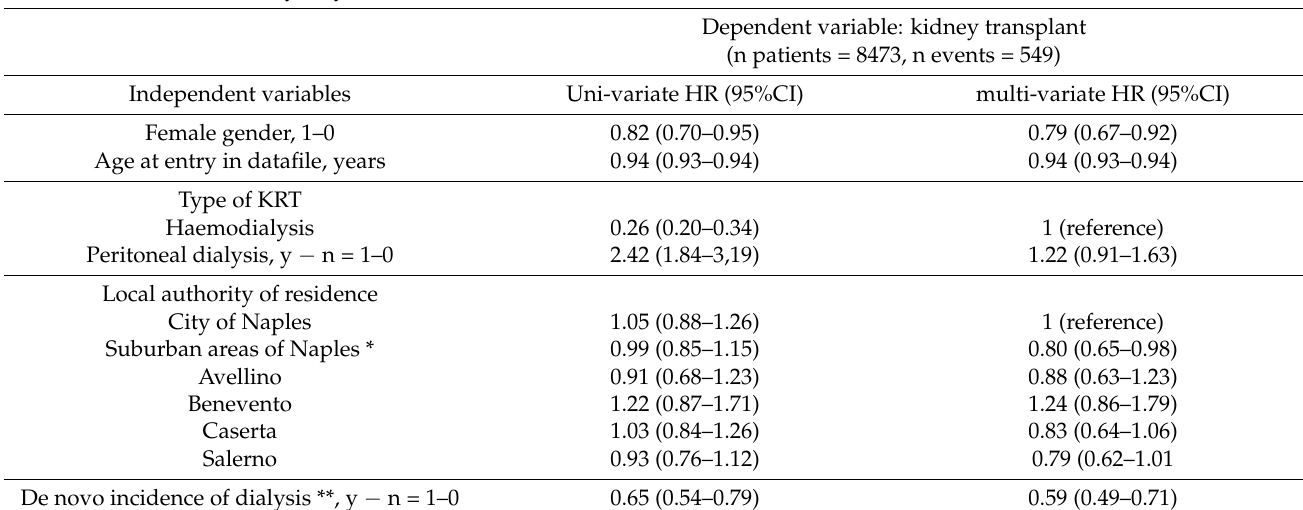
* Suburban area of Napoli 2 nord and suburban area of Napoli 3 sud combined together, ** incidence from 2015 to 2018 included. KRT: kidney replacement